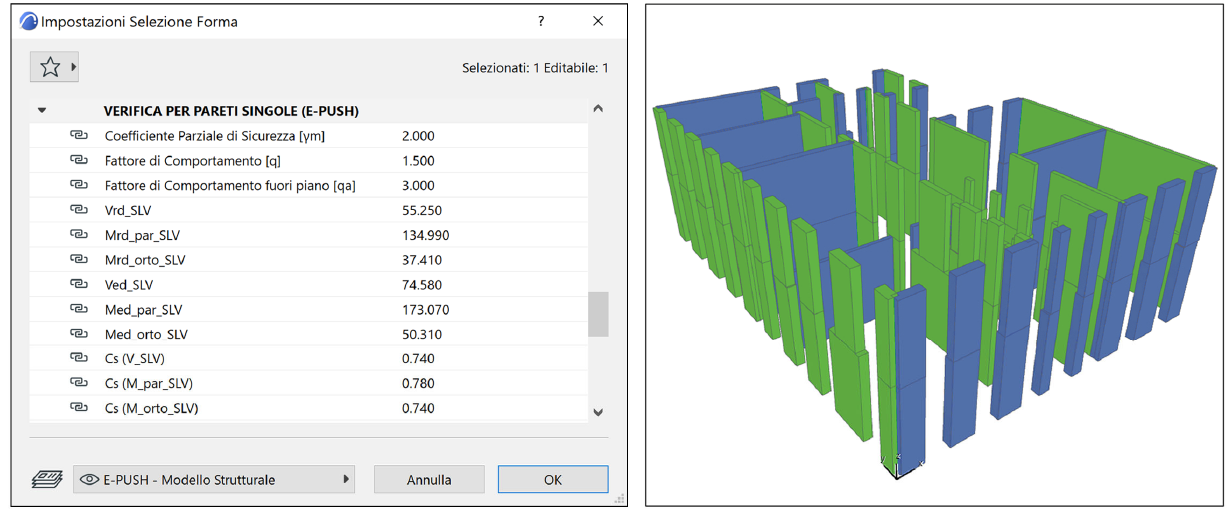
Figure 13. Analysis Model: collection of analysis results for the considered case study in Archicad.